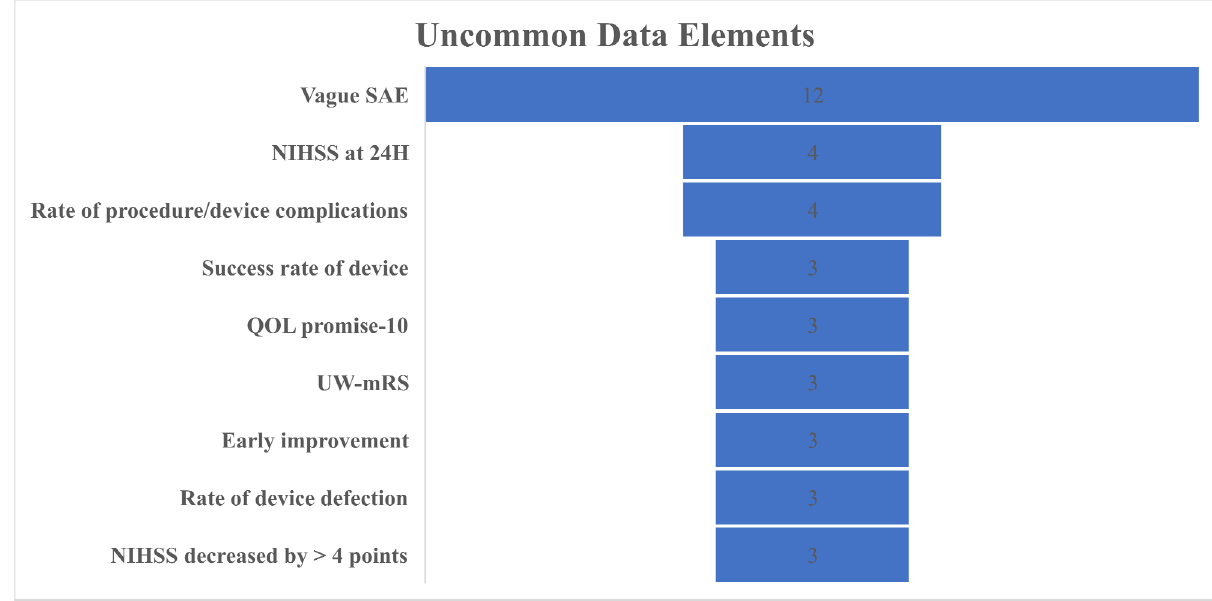
Figure 4. Frequency of uncommon, heterogeneously presented data elements. SAE: serious adverse events; NIHSS: National Institutes of Health Stroke Scale; QOL: quality of life; UW-mRS: utility- weighted modified Rankin Scale.